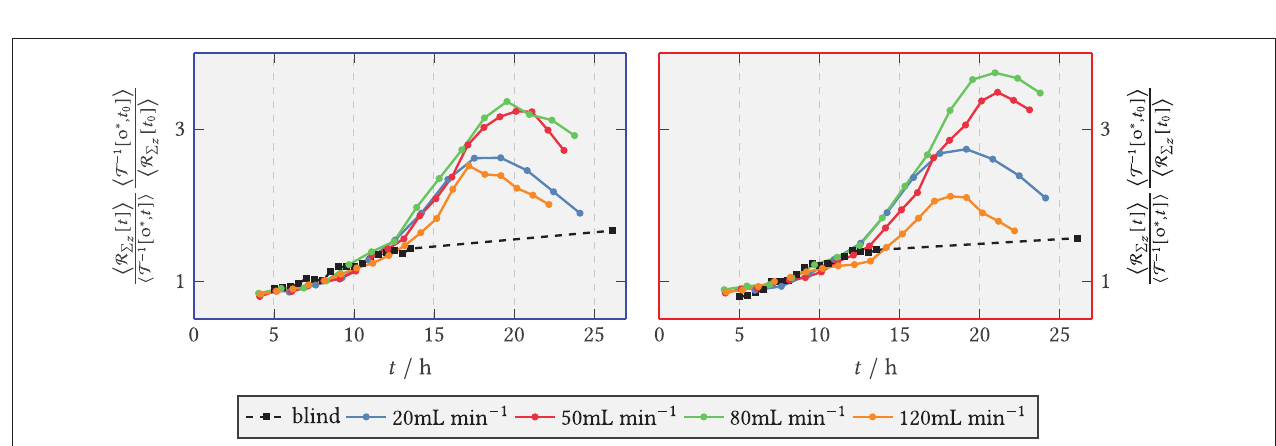
FIGURE 13 | Relative axial red fluorescence ( R ) sum of tagged glucoamylase for ˙ V = 20,50,80,120 mLmin − 1 and the blank sample (shear-free medium exchange). The light extinction was normalized to the initial extinction at t 0 = 9 h. (Left) ZONE behind the step (recirculation zone); (Right) Zone downstream of the step, x / s > 15 (after reattachment).